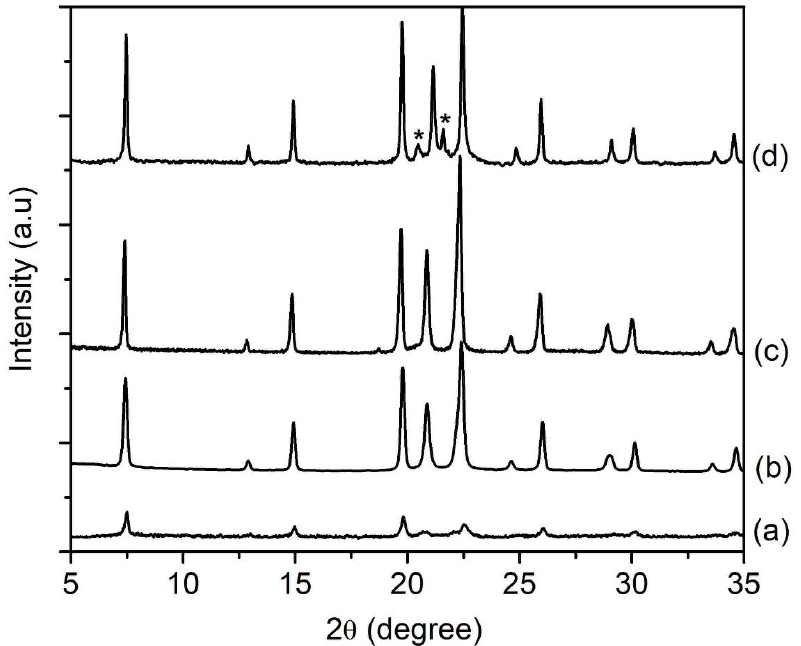
Figure 7. XRD patterns of ( a ) SH12 ( y = 135), ( b ) SH4 ( y = 180), ( c ) SH13 ( y = 225) and ( d ) SH14 ( y = 270) solid products, which were prepared using precursor hydrogels with a molar composition of1Al 2 O 3 :2.5P 2 O 5 :2.5[bzmIm] 2 O: y H 2 O:0.47SiO 2 heated at 150 °C for 10 h. The asterisks show the presence of tridymite dense phase.